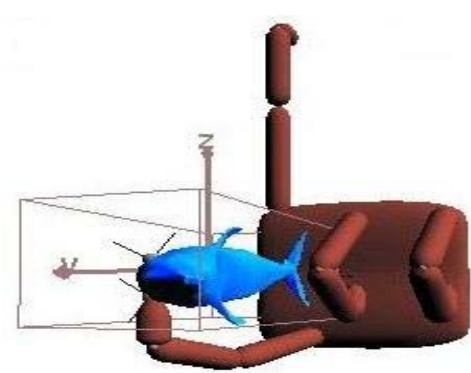
Figure 17 Results with Odd Cases-A